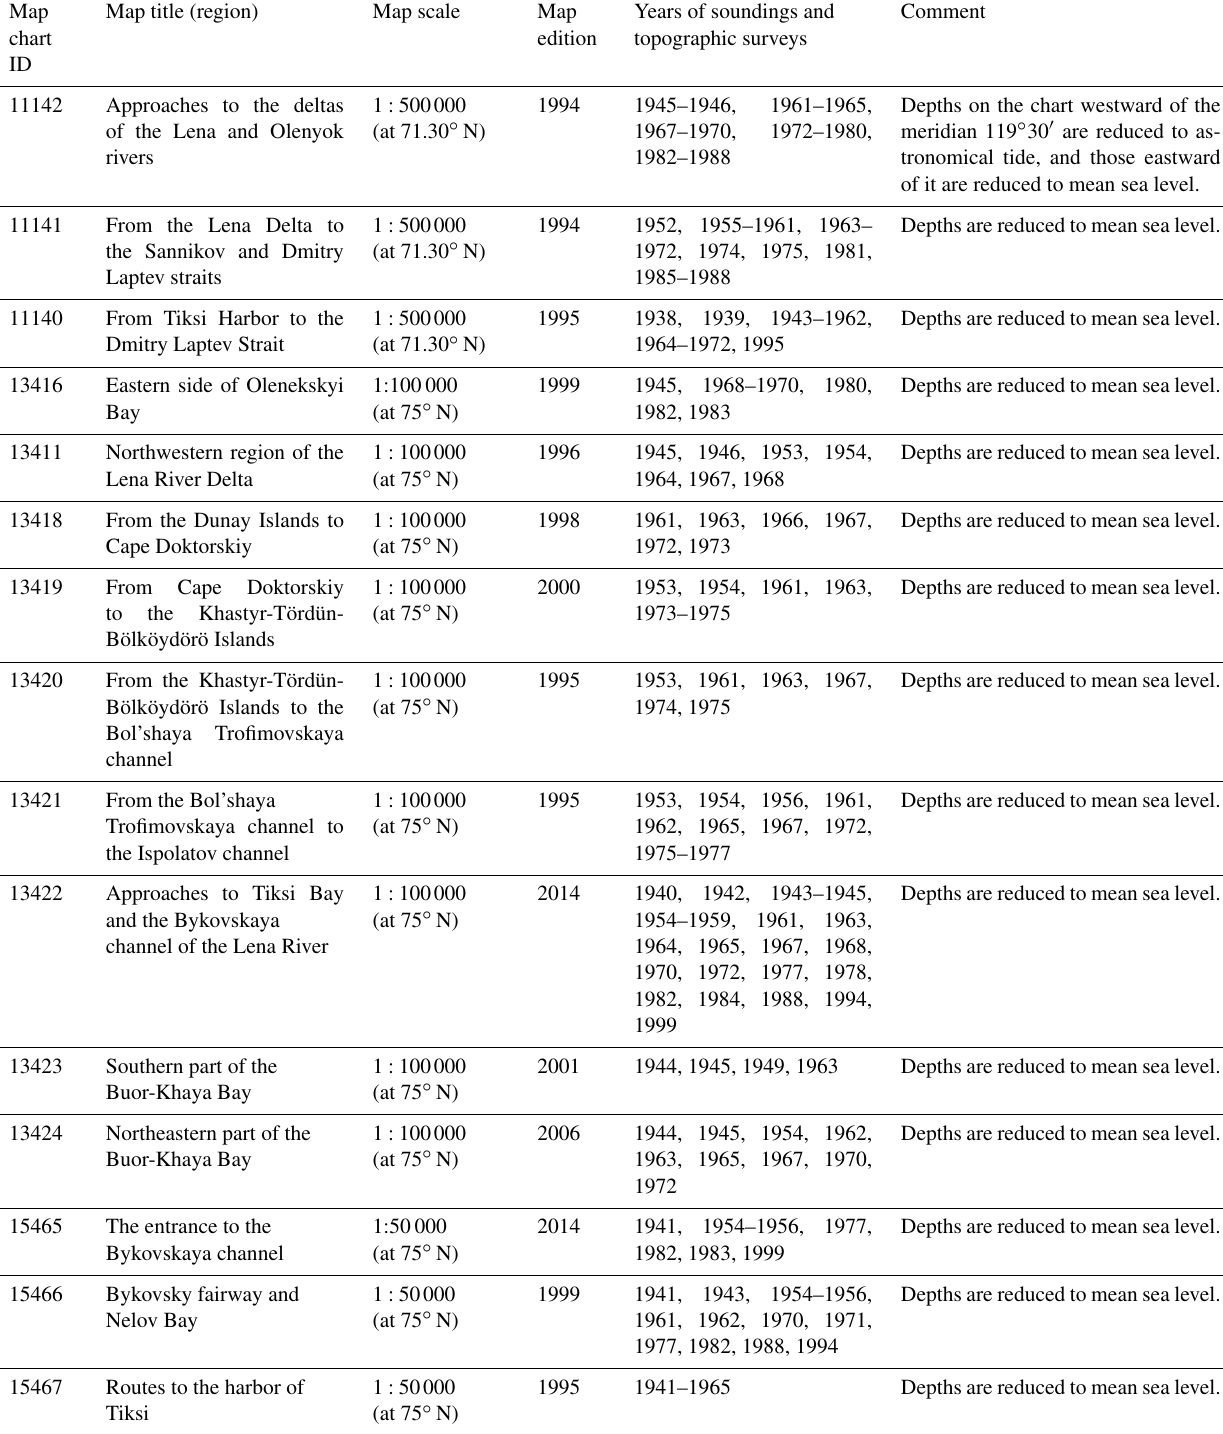
Table 1. Map charts from the Lena Delta